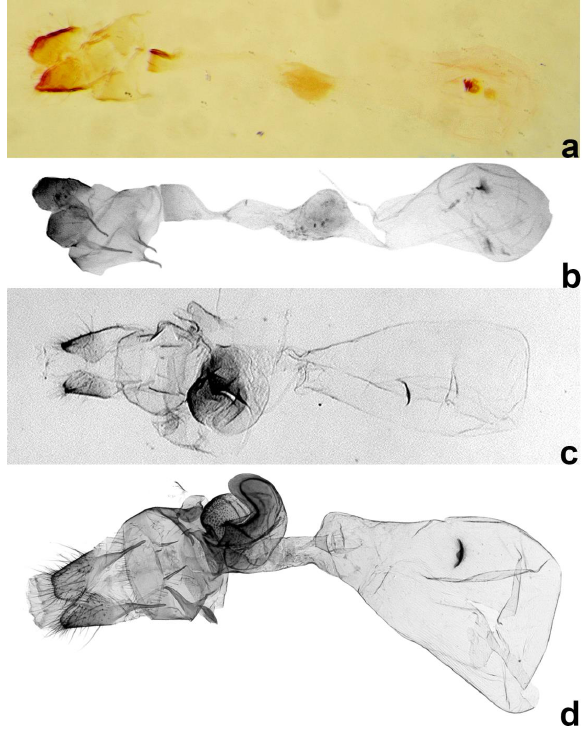
Figure 5. Female genitalia of Nola spp: ( a ) N. costimacula , holotype of Celama innocua var. japonibia (NHMUK, Arctiidae genitalia slide No. 1775); ( b ) ditto , ex coll. Inoue (NHMUK, Arctiidae genitalia slide No. 1818); ( c ) N. innocua , holotype (NHMUK, Arctiidae genitalia slide No. 1778); ( d ) ditto , (MWM/ZSM, gen. slide No. LGN 1903).